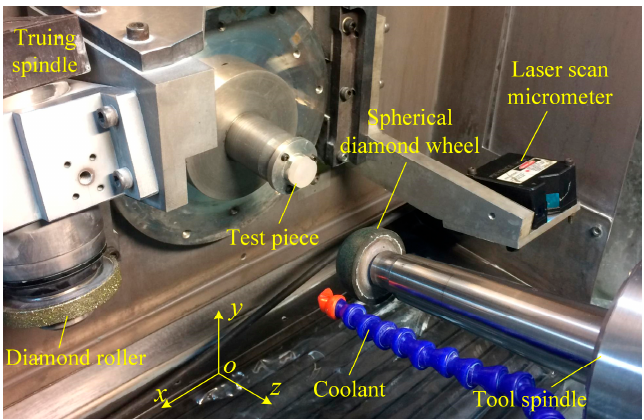
Figure 1. Inclined axis grinding system with a spherical diamond wheel.